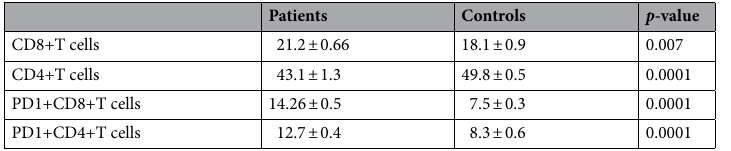
Table 2. Differential accumulation of T lymphocytes and PD 1 expressing T lymphocytes between study groups. Data expressed as mean ± SE, independent sample t-test and Mann Whitney U test for significance, p < 0.05.